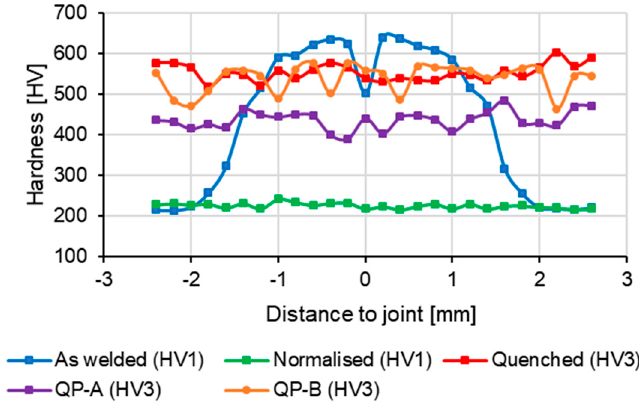
Figure 8. Hardness distributions of HFI welded 42SiCr pipes across the weld for the di ff erent material conditions of this study.